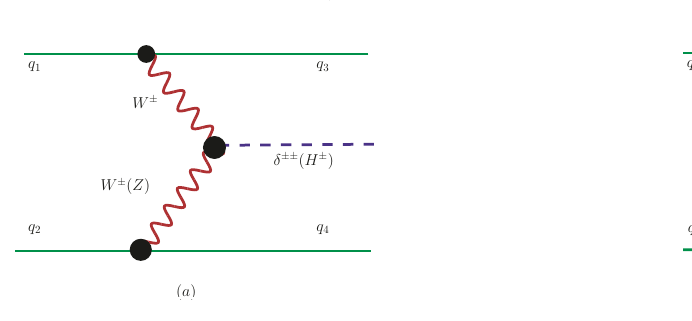
Figure 9. Pair production of charged scalar (singly and doubly) through neutral gauge boson prop- agator in s -channel. The [ ] depicts the modi(cid:12)ed Feynman vertex (renormalizable + corrections (cid:15) due to dimension-6 operators).